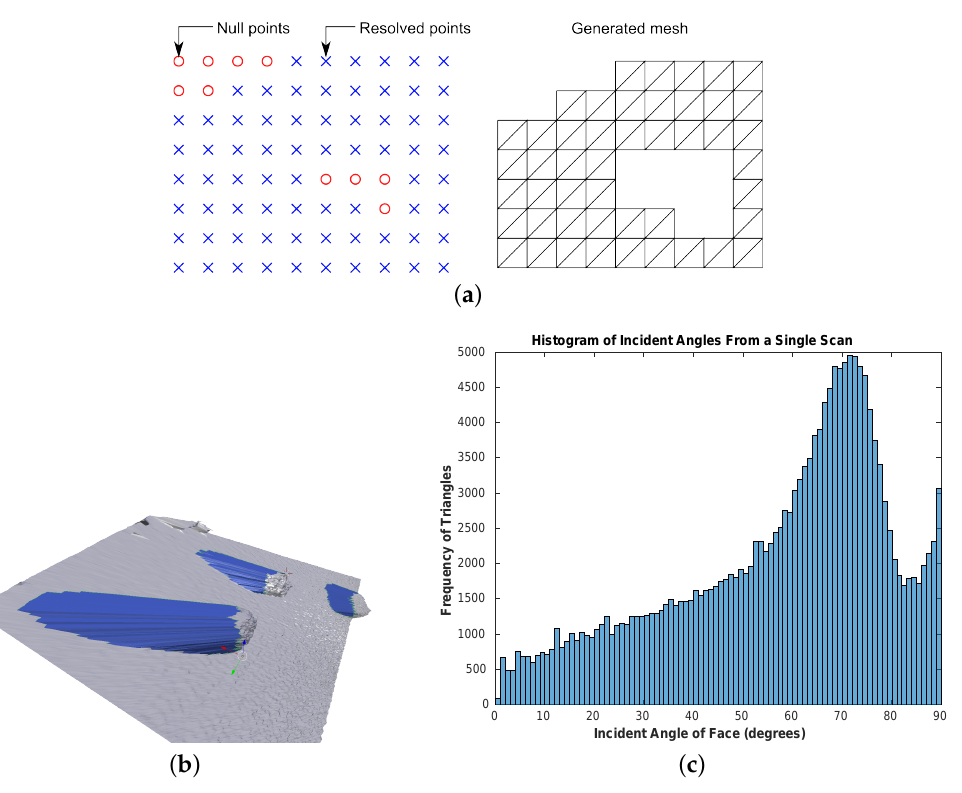
Figure 14. Triangulation of a structured point cloud ( a ); false surface regions shown in blue generated by the mesh triangulation process ( b ); and the histogram-based frequency distribution of the incident angles for a typical scan with large occluded areas ( c